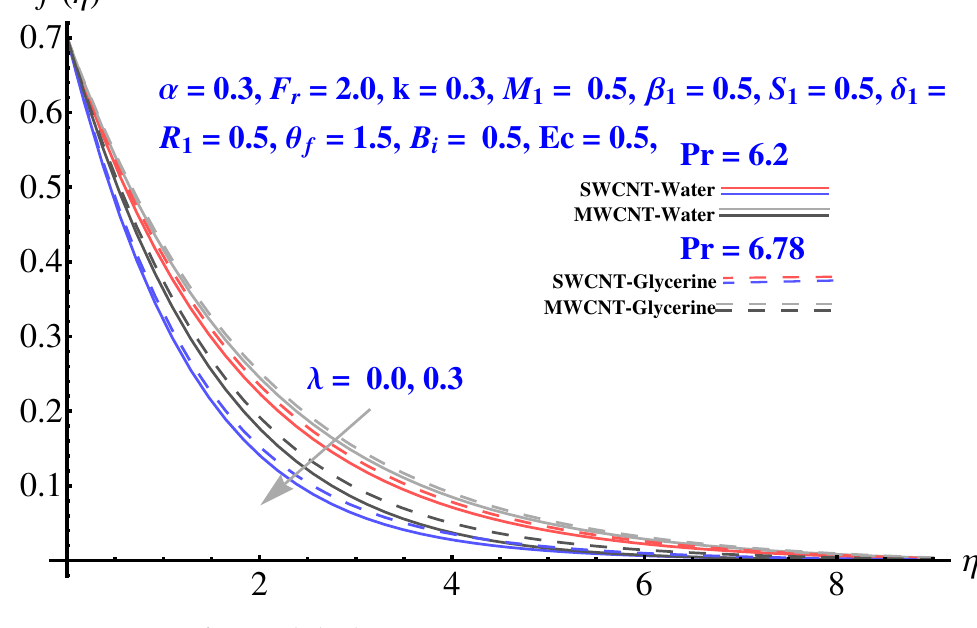
Figure 4. Impact of λ on radial velocity.